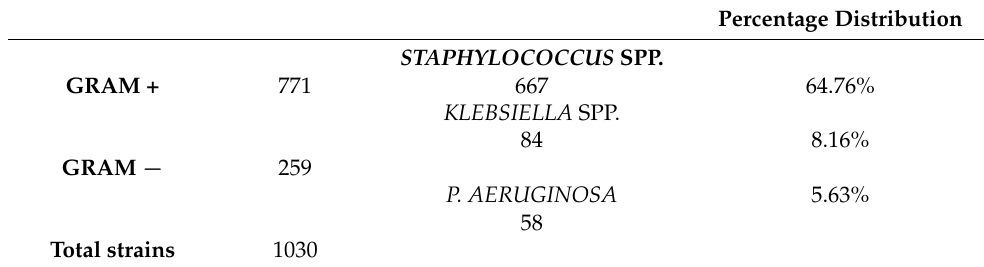
Table 4. Distribution of frequently identified microorganisms depending on Gram stain.